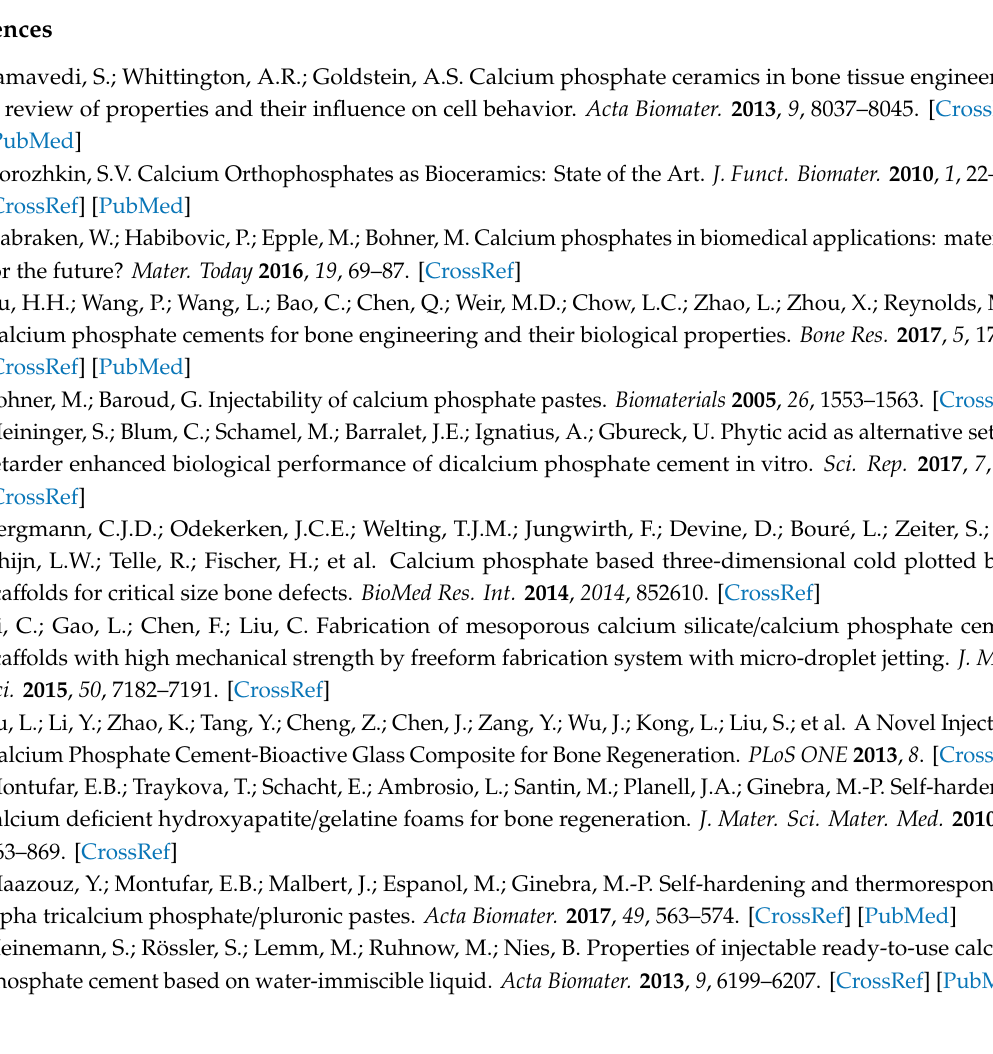
Figure S1: Particle size distribution of MBG particles. Figure S2: Influence of MBG particle size on extrusion behavior in needles with inner diameters of 610 µ m, 410 µ m and 250 µ m. Figure S3: Stereomicroscopical images of three-dimensional plotted CPC and 4%-, 6%- and 8%-MBG-CPC composite sca ff olds. Figure S4: Mass distribution of the plotted and bulk sca ff olds investigated in Sr and Ca release